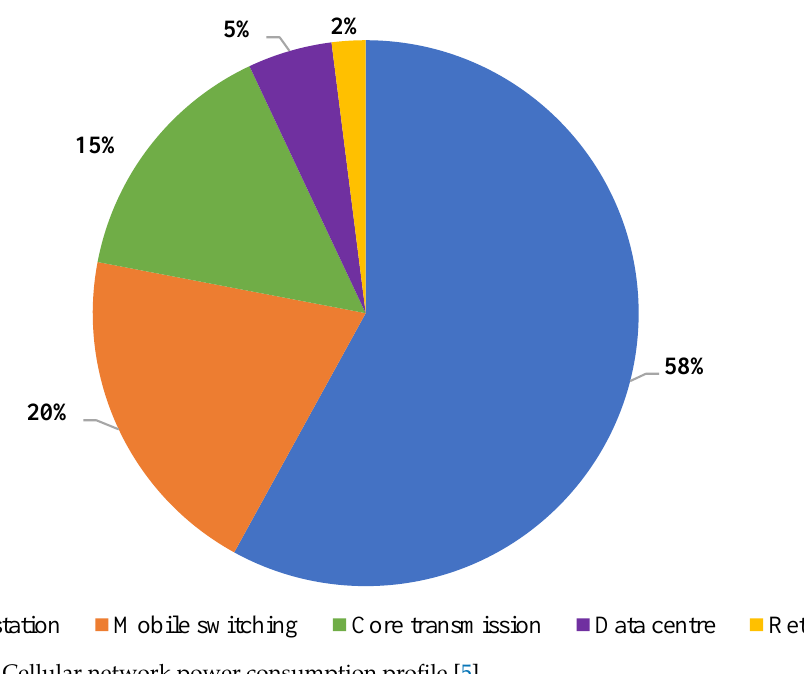
Figure 1. Cellular network power consumption profile